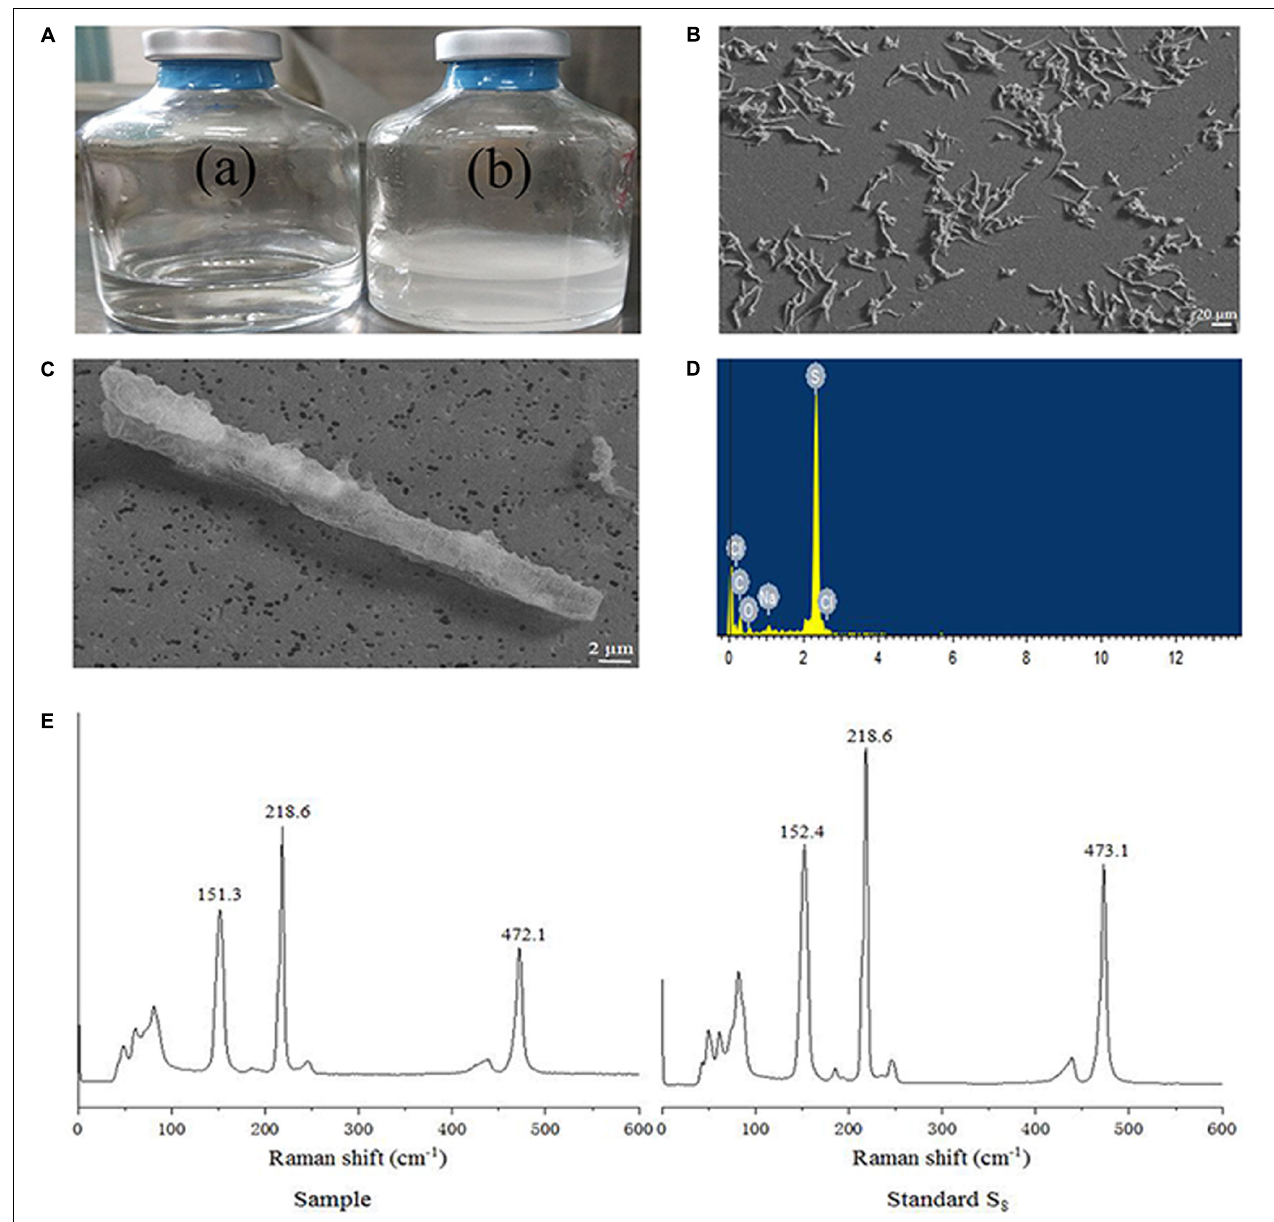
FIGURE 3 | S. hydrogeniphila NW10 T produces extracellular sulfur when cultured in MMJHS medium. (A) Strain NW10 T cultured in MMJHS medium without (a) or with 10 mM thiosulfate (b). (B,C) SEM observation of S 0 particles produced by strain NW10 T . (D) Energy dispersive spectrum analysis of extracellular S 0 . (E) Raman spectra of extracellular S 0 produced by strain NW10 T and standard S 8 .